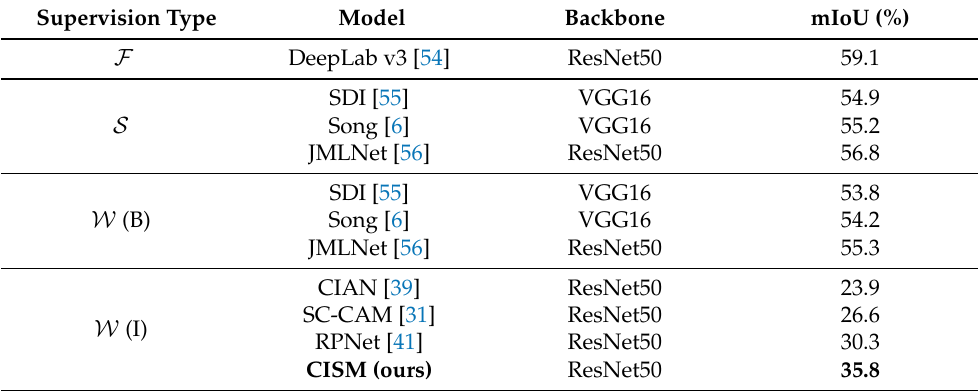
Table 2. Evaluation results on the iSAID dataset under the different supervision types. We use different symbols to distinguish the type of supervision: F indicates full supervision. S indicates semi-supervision. W indicates weak supervision, where W ( B ) denotes bounding box supervision and W ( I ) denotes image-level